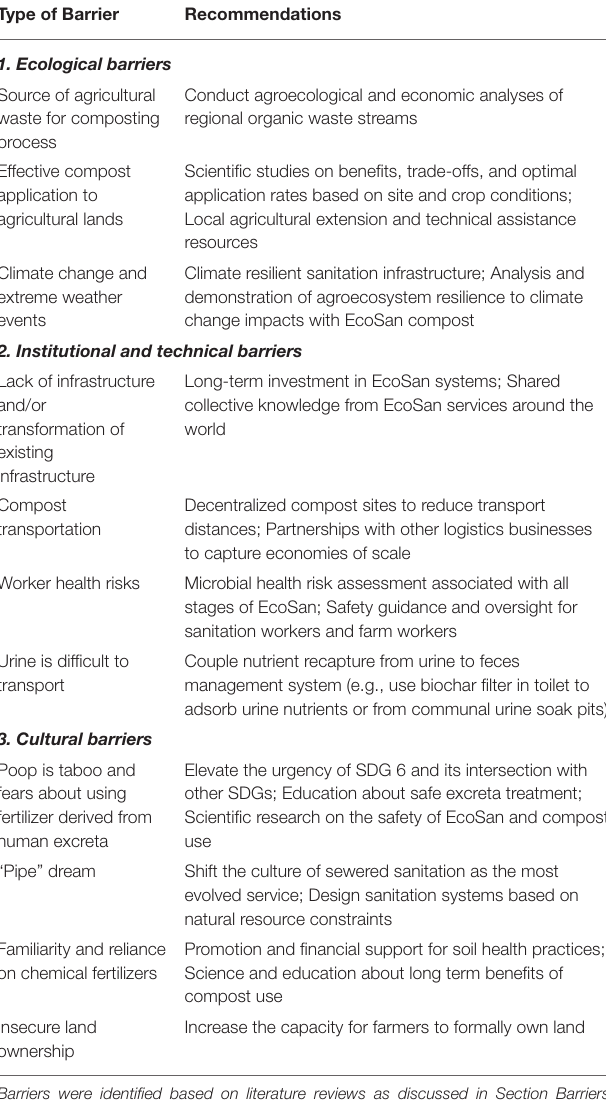
TABLE 4 | Barriers to adoption of EcoSan and recommendations to overcome